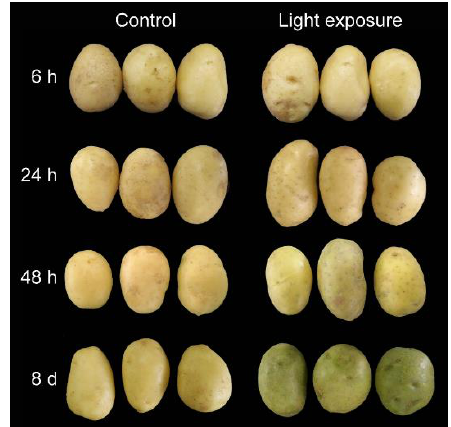
Figure 1. General appearance of potato tubers subjected to light exposure. Tubers were exposed to constant white fluorescent light in a growth cabinet for the time points indicated (6 h, 24 h, 48 h, and 8 d). Additionally, for the control, potatoes were placed in the dark in the same cabinet.